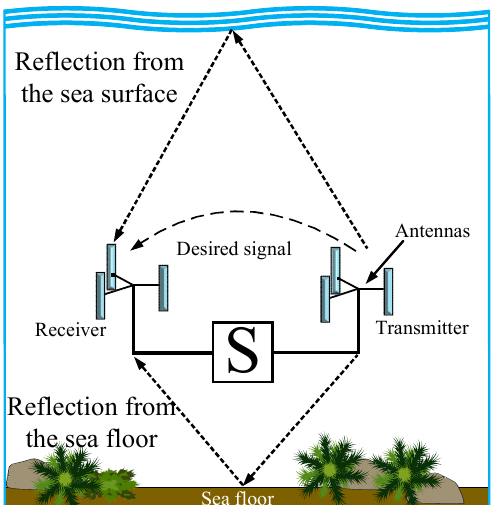
Figure 3. Self-multipath interference of IBFD acoustic system in shallow water.